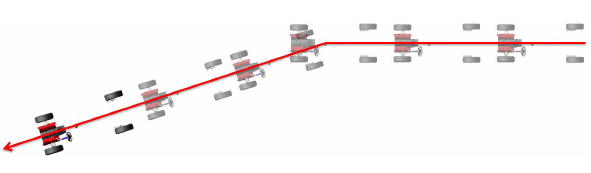
Figure 12. Schematic illustration of impulse steering test travel